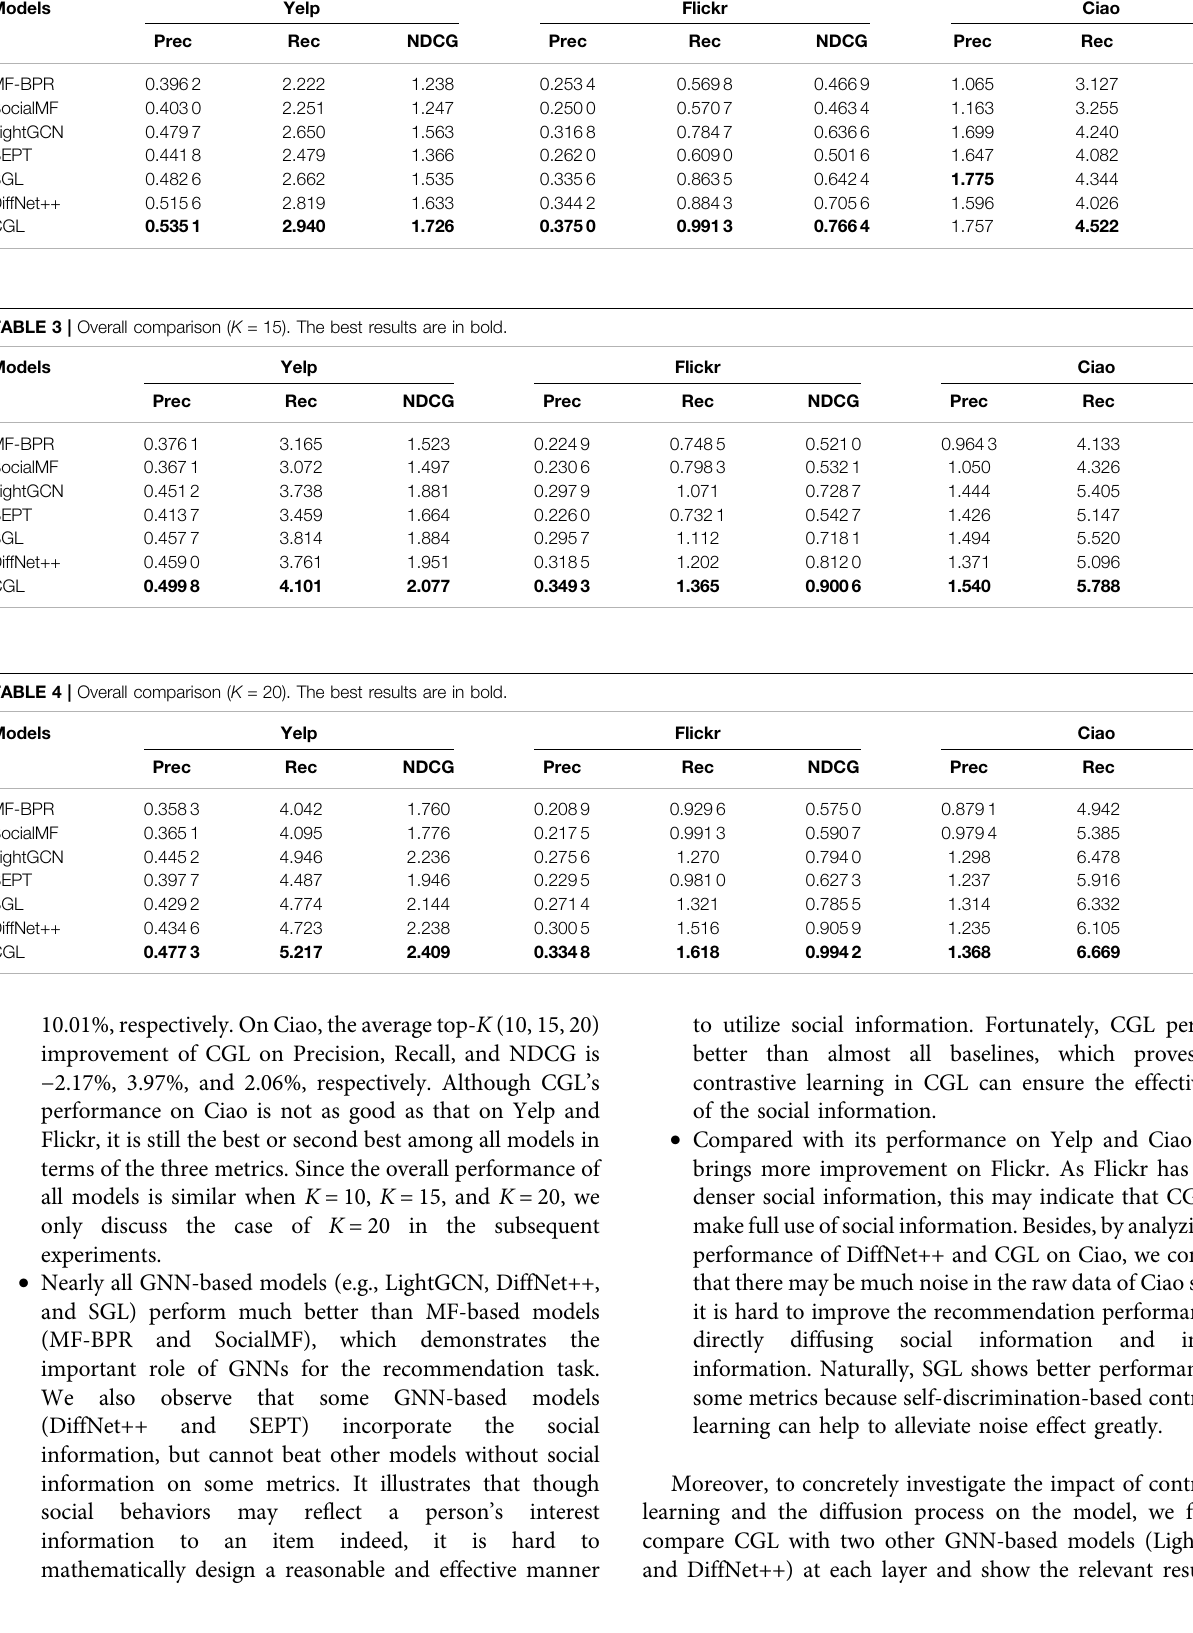
TABLE 2 | Overall comparison ( K = 10). The best results are in bold. Models